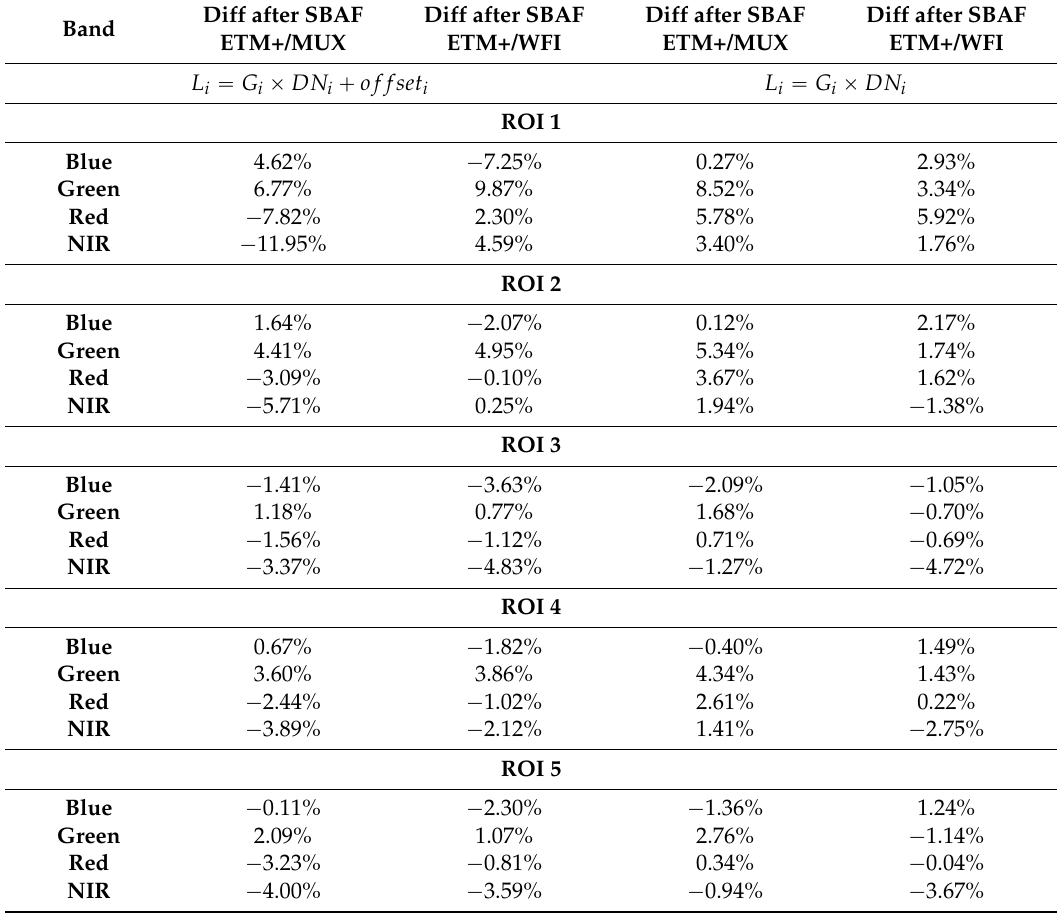
Table 9. Landsat-7 and CBERS-4 percentage difference in TOA reflectance of the five